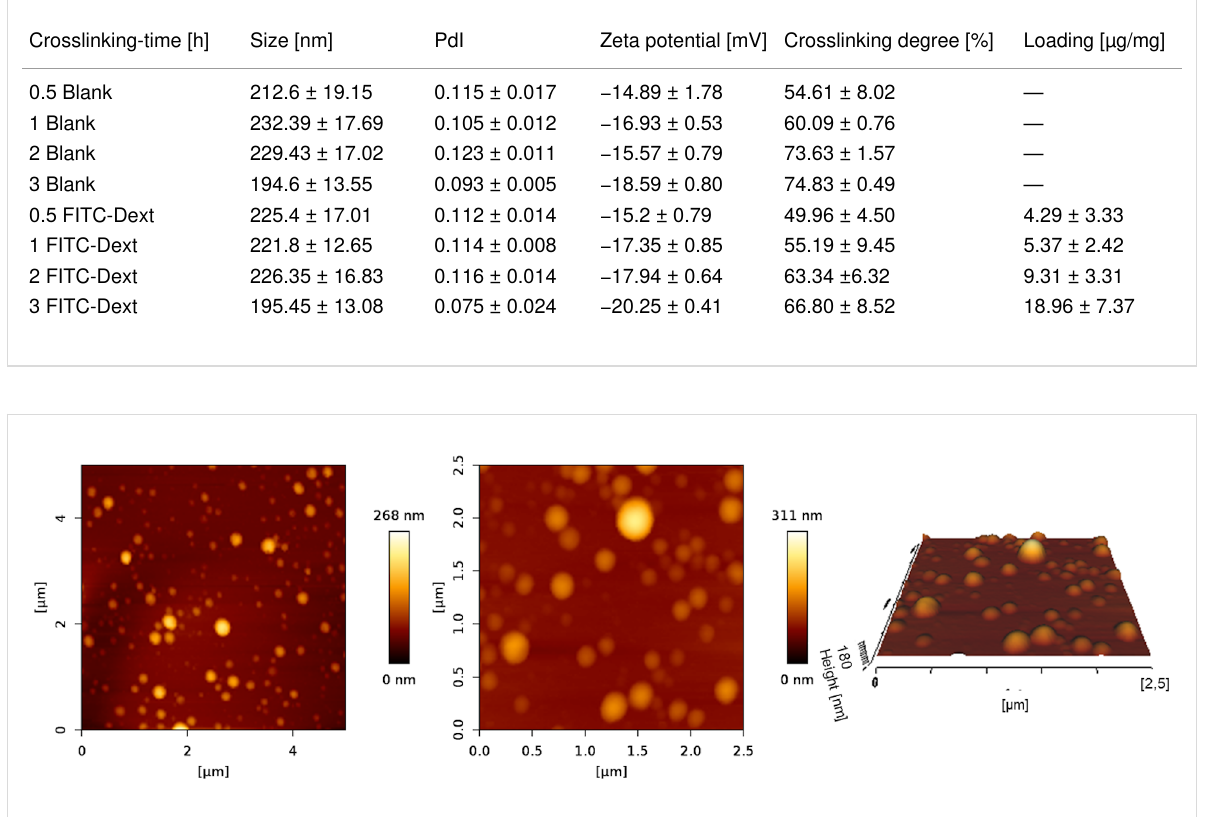
Table 1: Physicochemical characterization of GNPs crosslinked for specific times, dextran-loaded with an initial loading of 1 mg FITC-dextran per 20 mg gelatin and blank particles. The size is displayed as mean z-average in nanometers, PdI values were calculated using the ZetaSizer Explorer software, the zeta potential at a pH of 7.5 is shown in millivolts, the crosslinking degree was determined using TNBS assay and displayed in % of free primary amine functions, and the loading of gelatin nanoparticles was obtained by fluorescence intensity measurements and is shown as micrograms FITC-dextran per milligram nanoparticles.